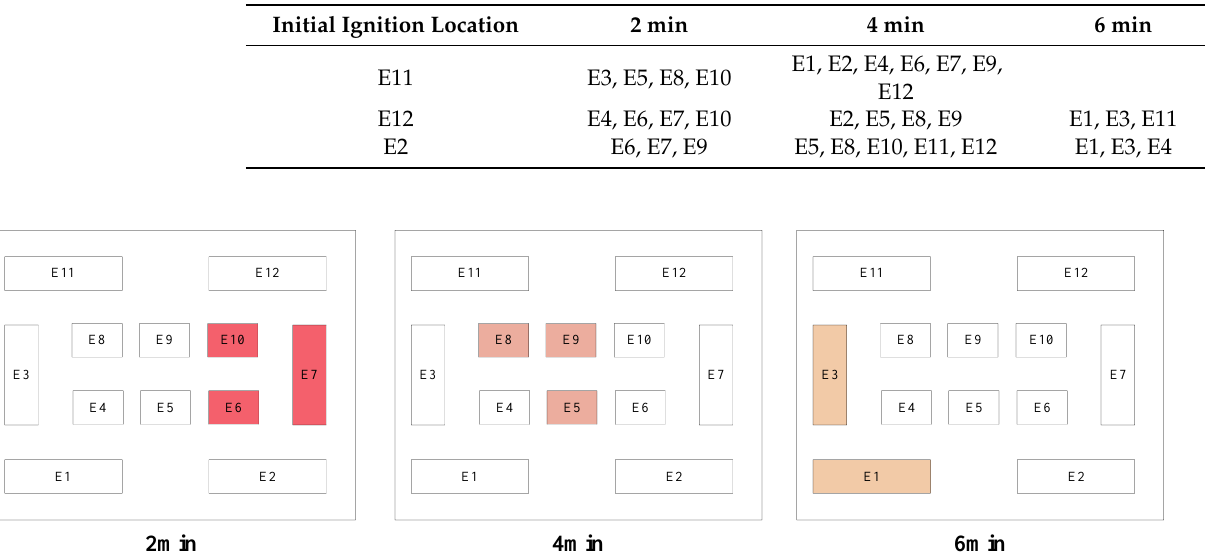
Figure 11. Key equipment in the engine room at an important time. Table 9. Vital time nodes of the engine room fire's domino effect evolution.